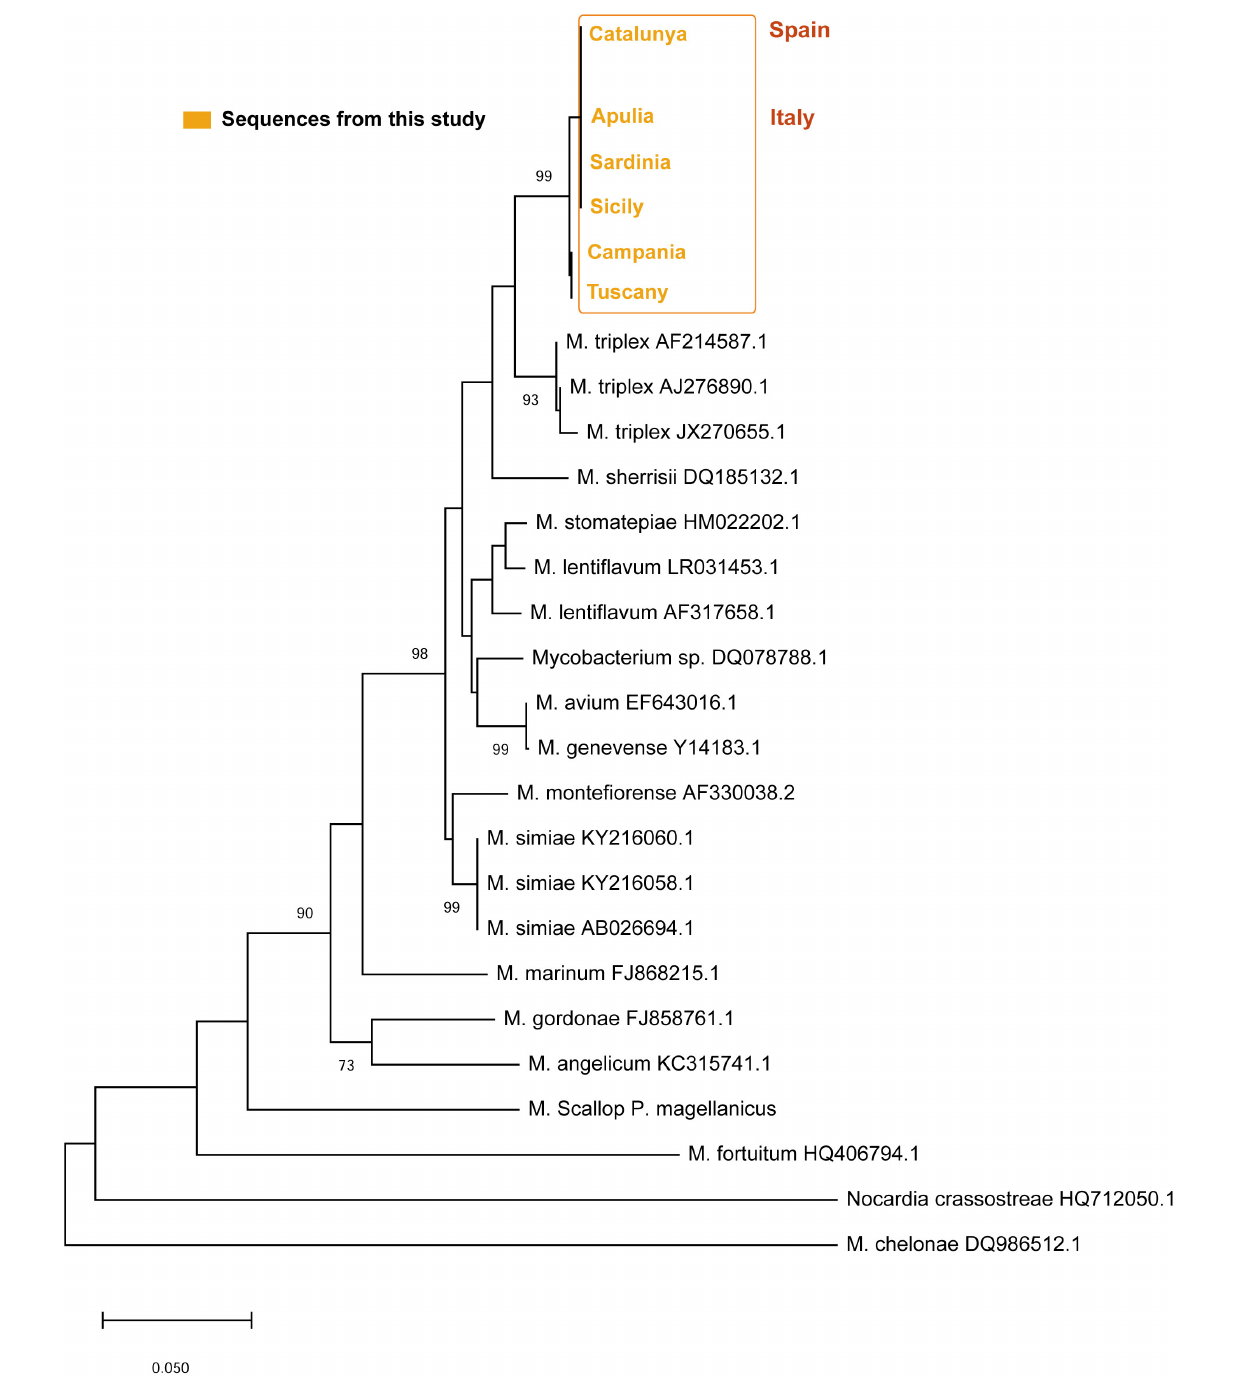
(Catanese et al., 2018), Greece (Lesvos Island) (Katsanevakis et al., 2019) also reported in Italy (Panarese et al.,